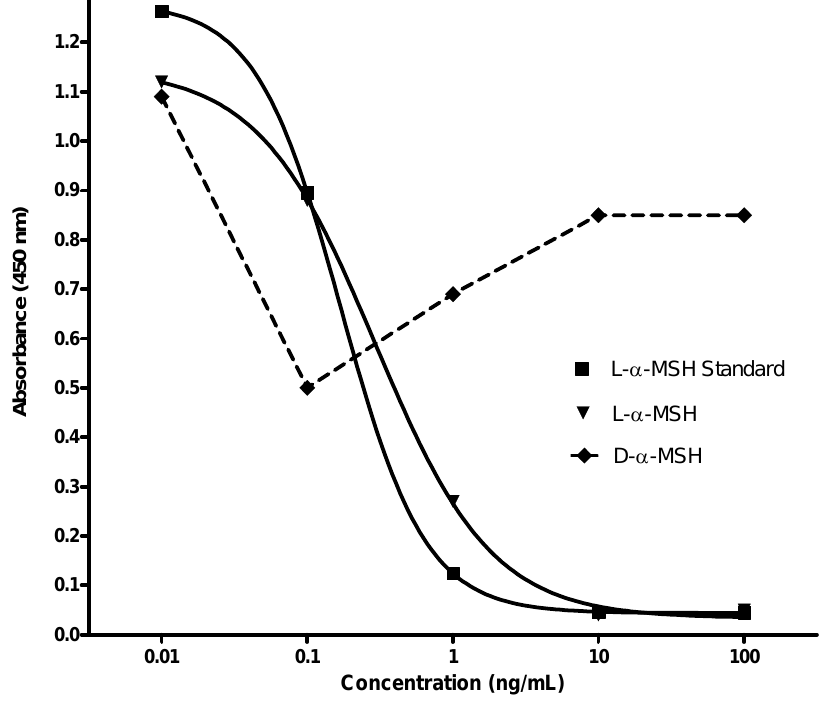
Figure 3. Detection of L - and D - α -MSH by means of competitive enzymatic